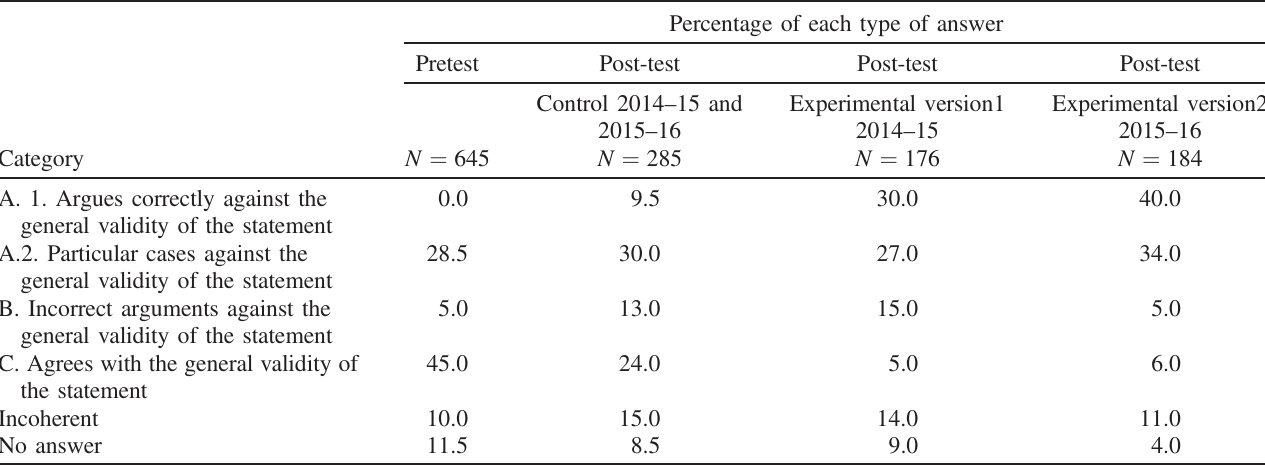
TABLE VI. Results to the question Q5 after the implementation of the